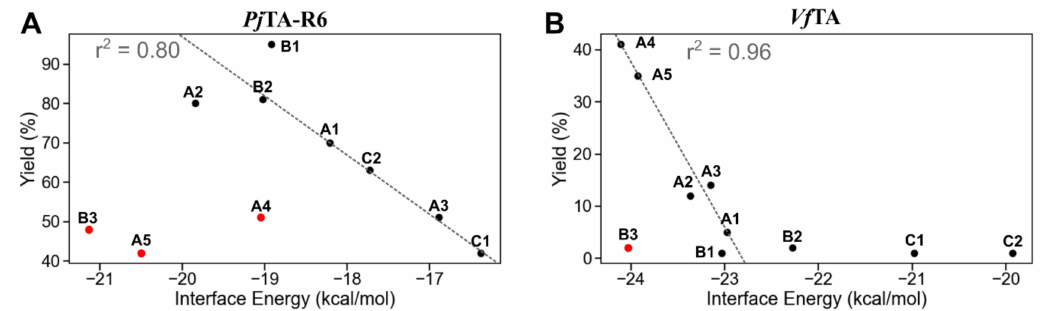
Figure 2. Interface energies of external aldimine complexes show a correlation with the observed activities. ( A ) Pj TA-R6 and ( B ) Vf TA. Outliers (red dots) were not considered for the linear regression (dotted line). For Pj TA-R6, this means the regression was made using compounds A1, A2, A3, B1, B2, C1, and C2. In the case of Vf TA, B1, B2, C1, and C2 were not considered for the linear regression as the product was hardly detectable ( < 2%). The Rosetta interface energy correctly predicted that B2, C1, and C2 would have very low yields; hence, these compounds were not